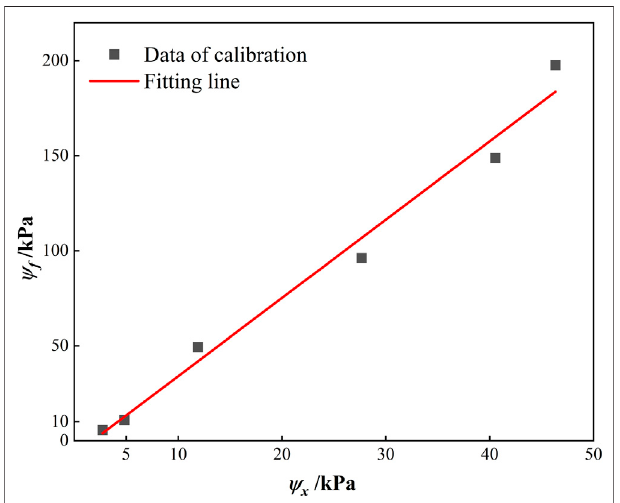
FIGURE 12 | WATERMARK sensor calibration curve after correction.